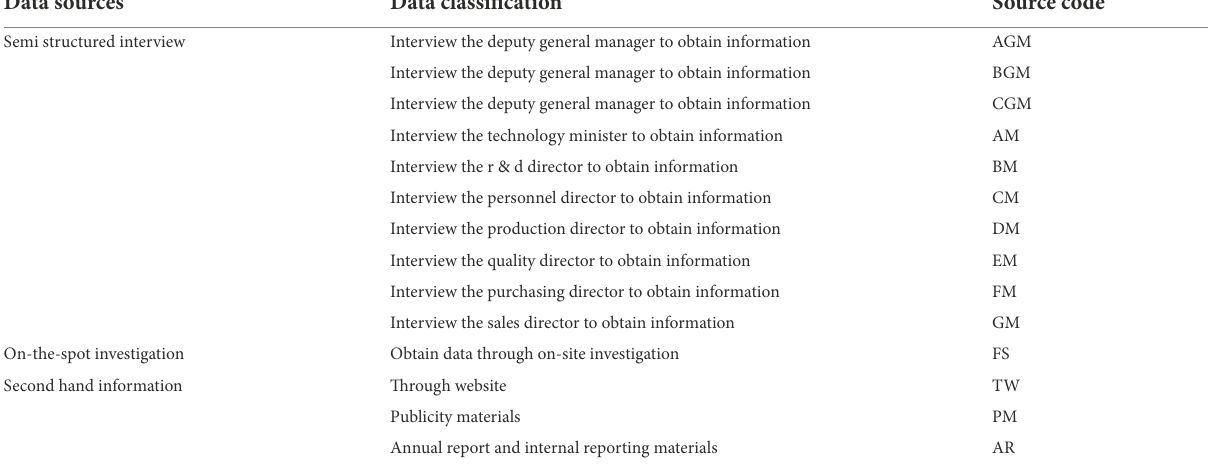
TABLE 2 Coding source